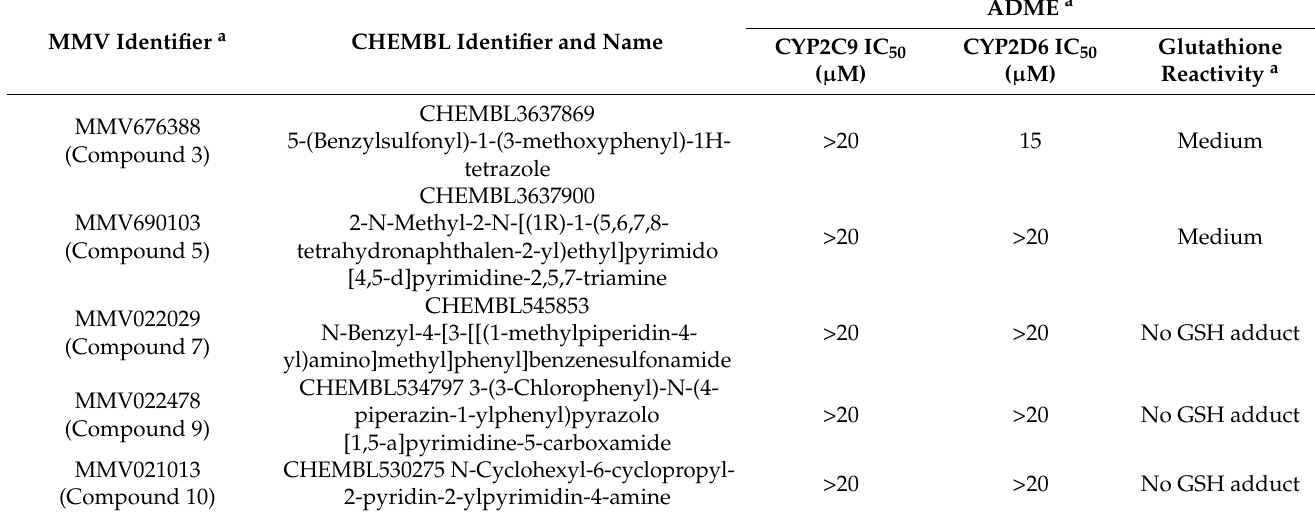
Table 4. Hit molecules and their characteristics. a : Data from mmv.org (accessed on 15 May 2021).